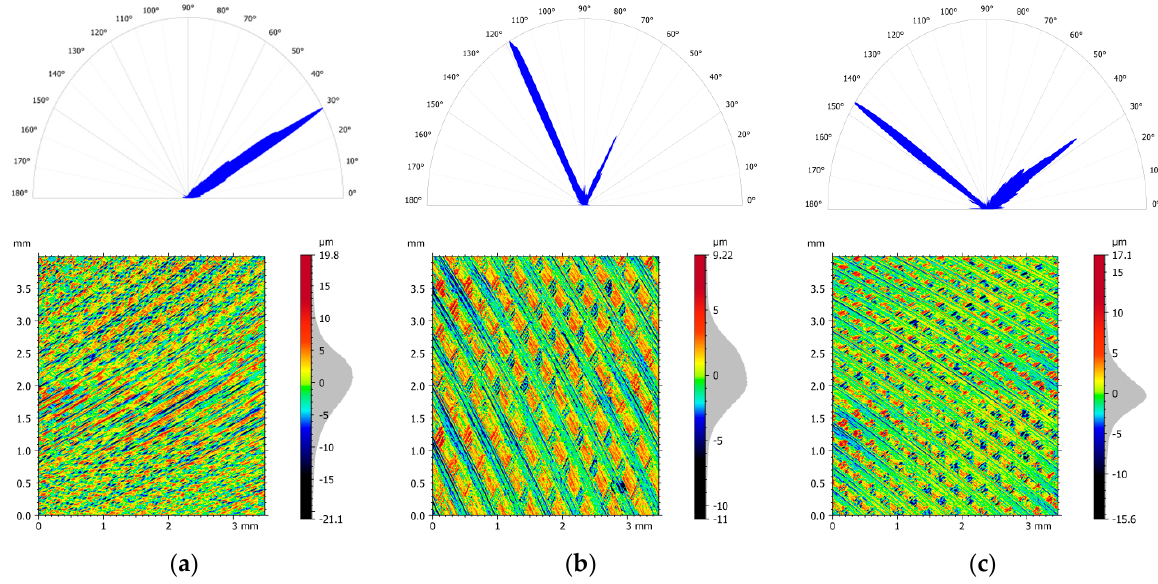
Figure 9. Orientation plot and the view of the surface texture for 6-mm-sample milled using strategy S#1 ( T_R rolling) and areas E#1 ( a ), E#4 ( b ) and E#5 ( c ).